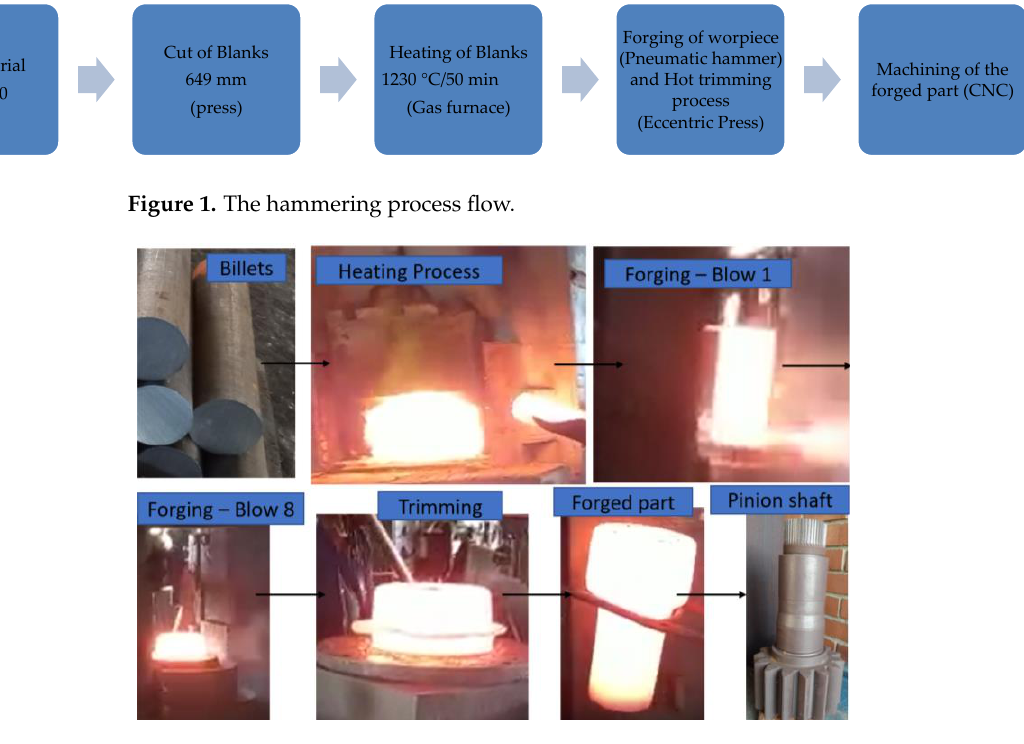
Figure 2. The sequence of the manufacturing process for the pinion shaft.